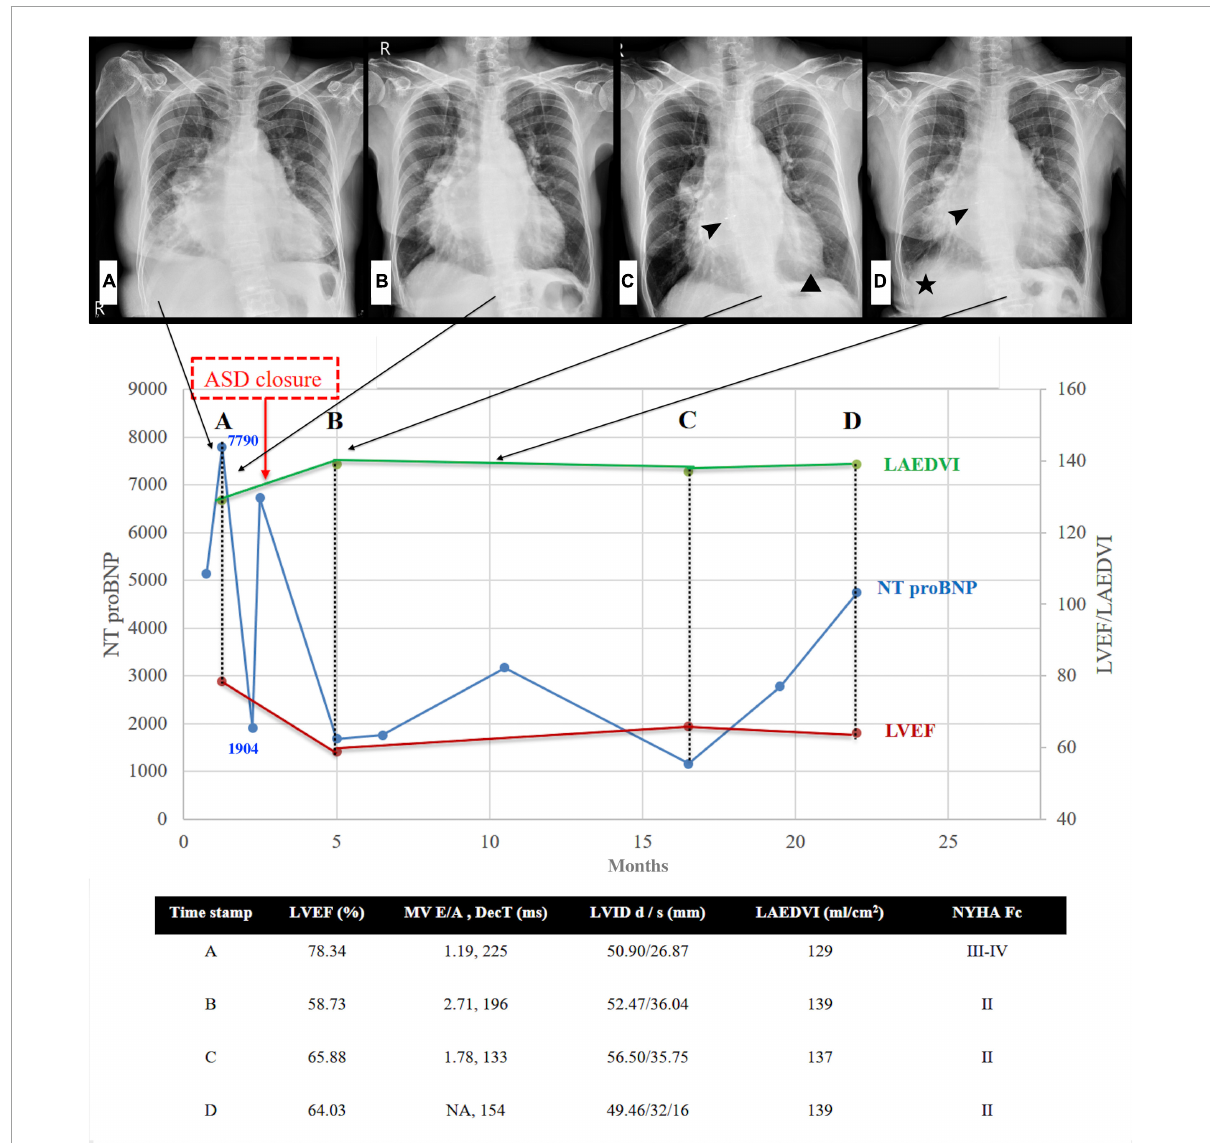
FIGURE1 Left heart disease progression after ASD closure. Serial chest radiographs (arrows indicated the timeline of CXR) and heart failure markers (NT proBNP & Echocardiography) before and after ASD closure. (A) CXR: cardiomegaly, moderate right-side pleural effusion, and bilateral lung congestion (B) CXR: pleural effusion and lung congestion improved after diuretics (C) CXR: minimal pericardial effusion (triangle) 2.5 months after closure, arrowhead: ASD occluder (D) CXR: evident right pleural effusion (asterisk) with increased lung congestion 8 months after